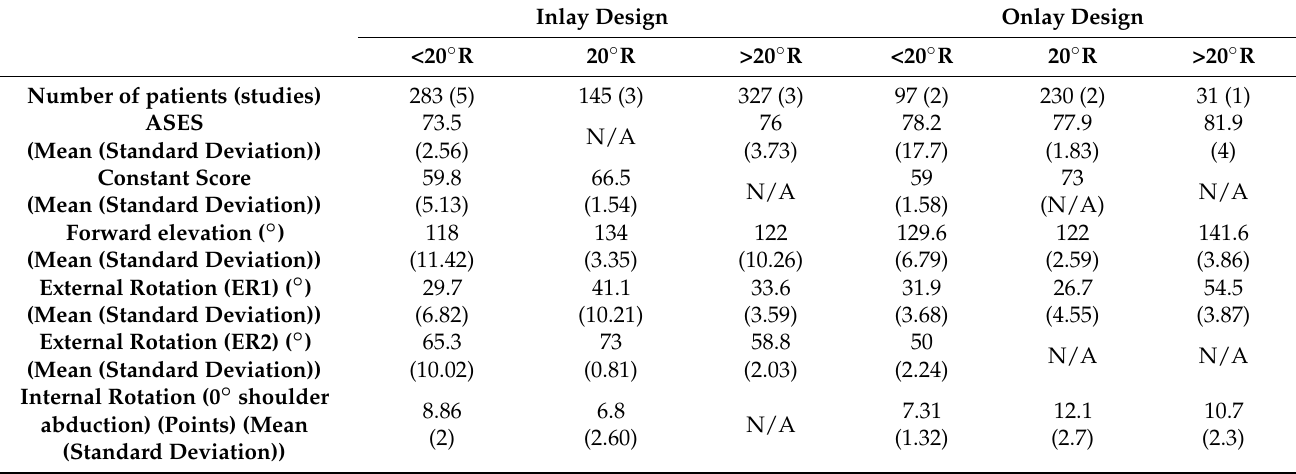
Table 7. Comparison of all three groups subdivided by humeral stem